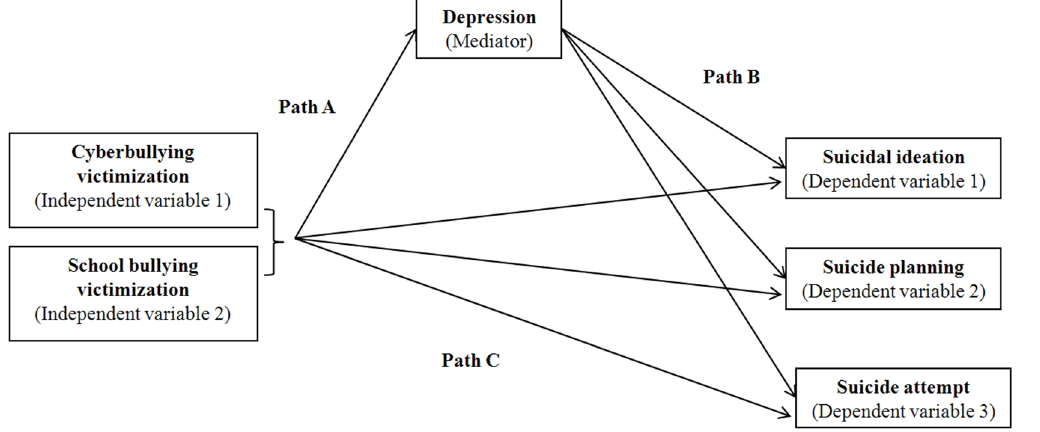
Figure 1. Mediational model for study of the relationship between cyberbullying and school bullying victimization and suicidal ideation, plans and attempts.